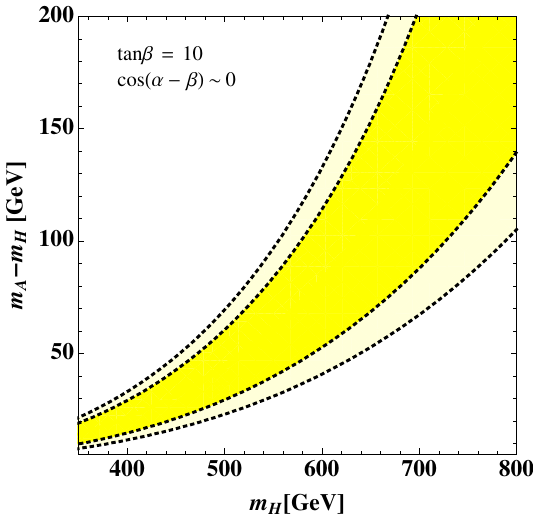
Figure 5 . The allowed region on f m H ; m A (cid:0) m H g plane satisfying B s { (cid:22) B s constraints with (cid:12)tting C 9 to explain b ! s‘ + ‘ (cid:0) anomalies where the yellow(light yellow) region corresponds to that in (cid:12)gure 1. Here we take tan (cid:12) = 10 and cos( (cid:11) (cid:0) (cid:12) ) (cid:24) 0 as reference values.